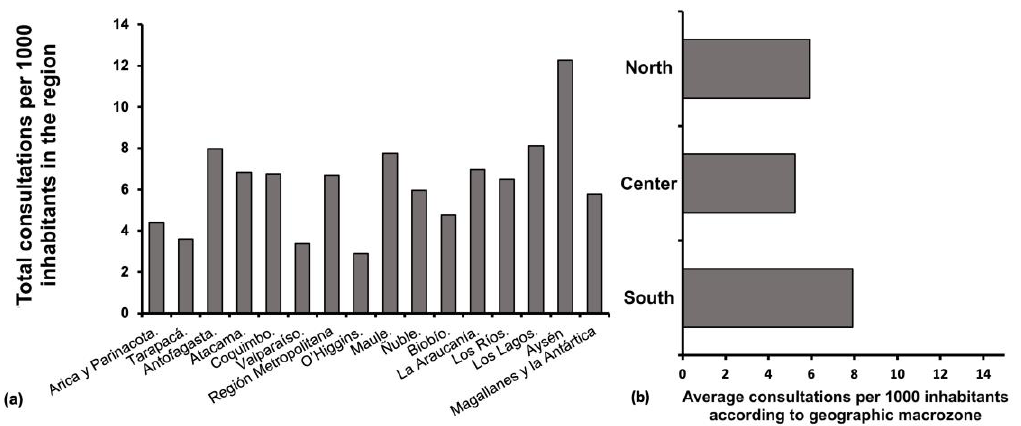
Figure 2. ( a ) Dermatology consultations in Chile’s public sector per 1000 inhabitants in each region, ordered from north to south from left to right. ( b ) Consultations to dermatology according to the average number of consultations per 1000 inhabitants by geographic zone (North, Center, and South) North zone covers the regions of Arica and Parinacota to Coquimbo. The central zone covers the regions of Valparaíso to Bío Bío. The South zone covers La Araucanía to Magallanes and Antarctica regions.